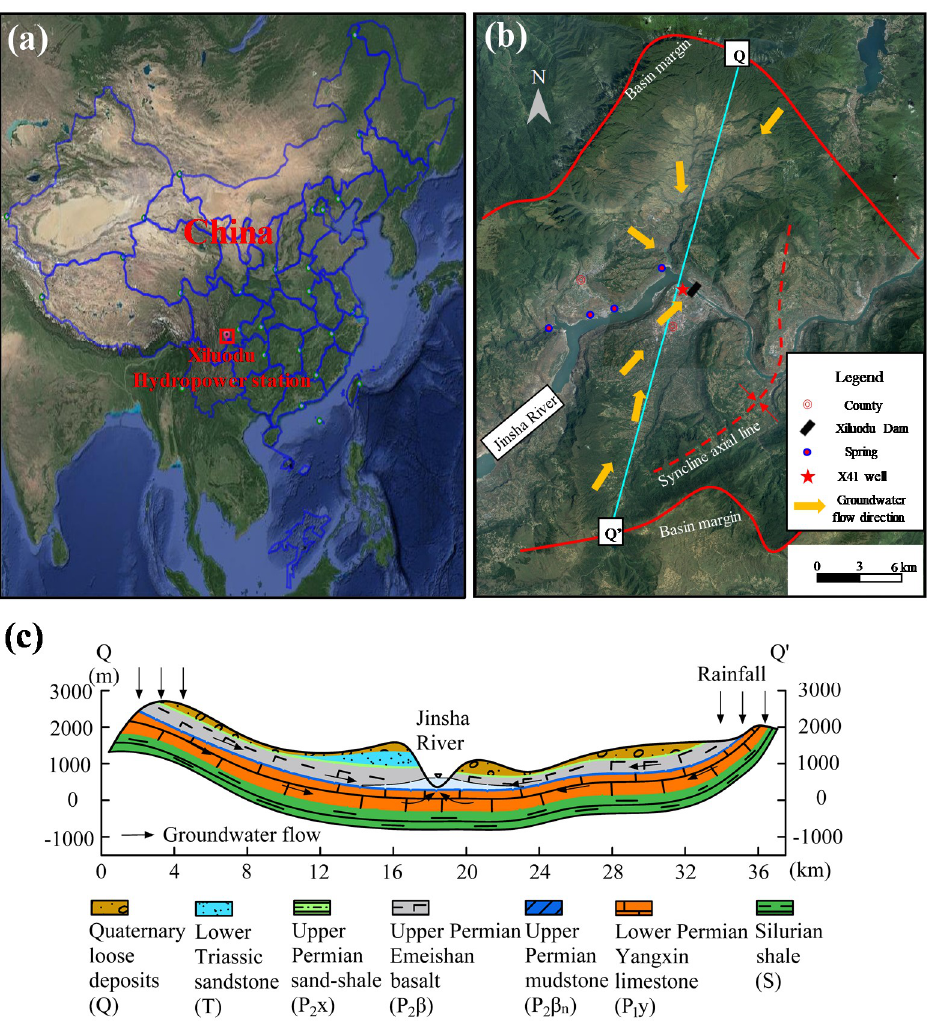
Figure 1. Geological overview of the dam area. ( a ) Location of the Xiluodu Dam. ( b ) Overview of the study area. ( c ) Cross-section of the Yongsheng synclinal basin. (( a ) and ( b ) are from OvitalMap software.)